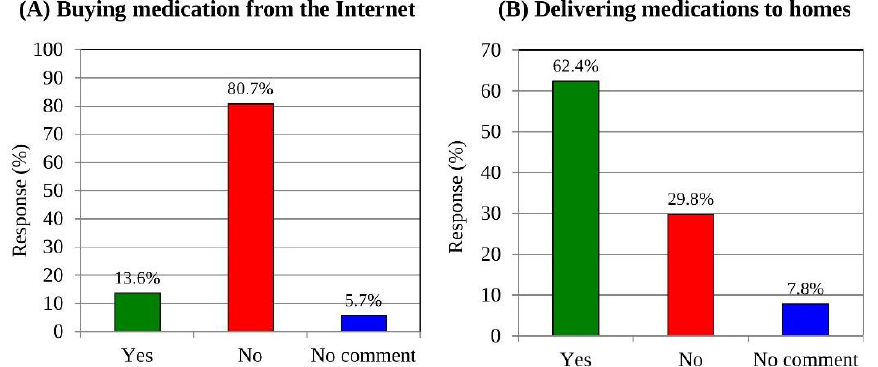
Figure 5. Categorical distribution of respondents’ responses to question on buying medicines over the Internet ( A ) and home delivery of medicines ( B ).